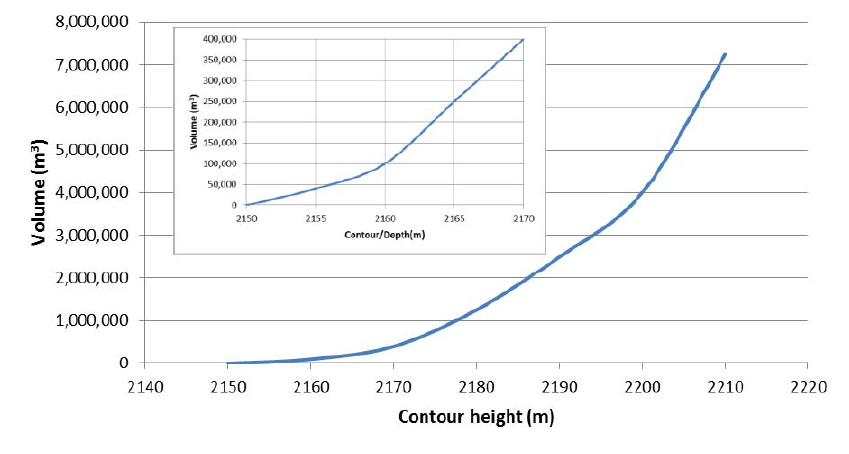
Figure 13. Curve plot of the proposed reservoir storage capacity versus estimated depth— p V ´ D q curve. Inset is a magnification of the storage volume between 2150 m and 2170 m.